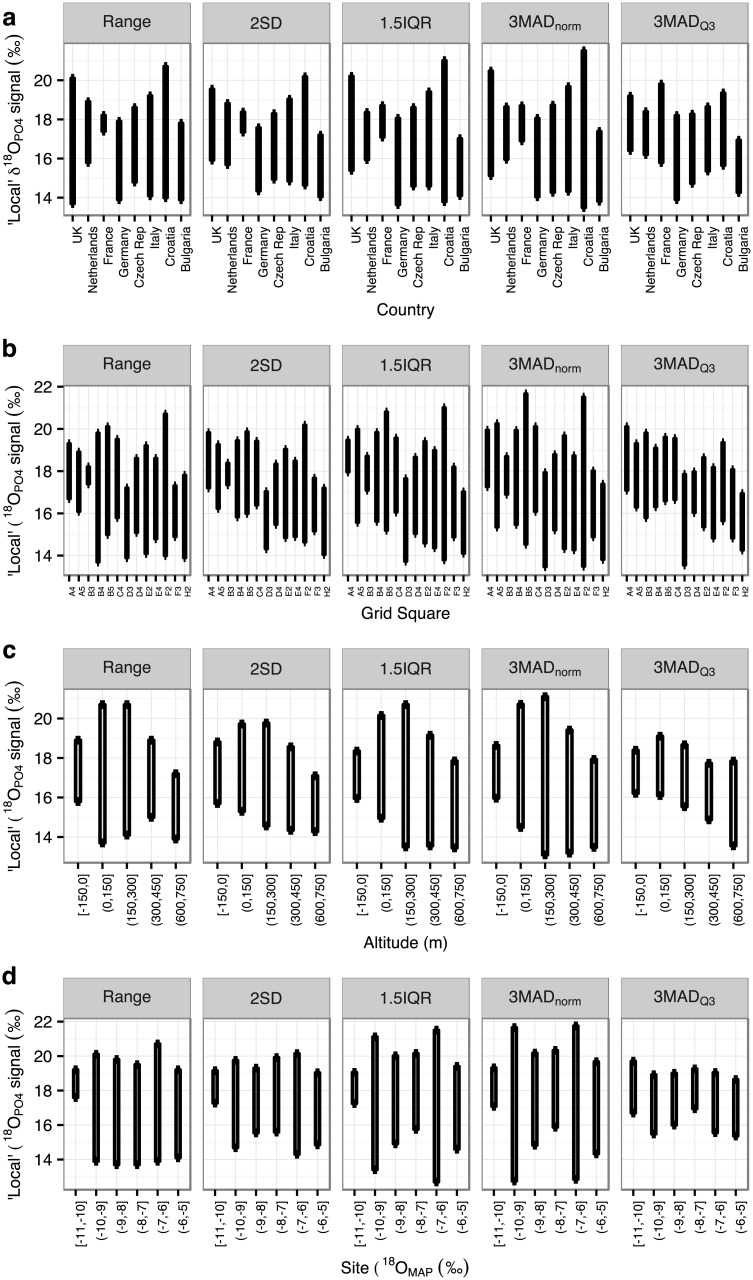
The limits of the ‘local’ signal of the different outlier identification methods for European sites, calculated: (a) by country, (b) by lat/long grid square, (c) by altitude, (d) by site-specific modern precipitation oxygen isotopic values (δ18OMAP).Plotted for groupings with N>4. Criteria of each method (2SD, 1.5IQR, 3MADnorm, 3MADQ3) as defined in the text. (a) Full data in S4 Table, the countries are statistically different: H(8) = 297.67, P<0.001. (b) Full data including alphanumeric codes in S5 Table, the grid squares are statistically different: H(12) = 312.50, P<0.001. (c) Full data in S6, data binned in 150m intervals, the altitudinal groups are statistically different: H(4) = 155.94, P<0.001. (d) Full data in S7 Table, δ18OMAP data binned in 1‰ intervals, the precipitation oxygen isotope groups are statistically different: H(3) = 93.78, P<0.001.